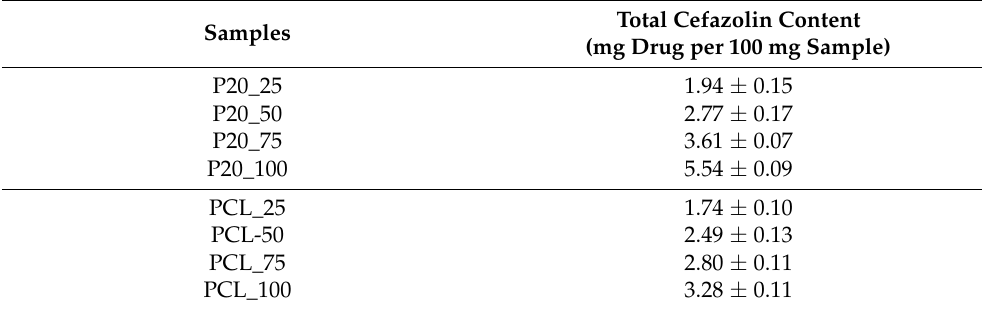
Table 2. Total cefazolin contents loaded in the samples. Data are expressed as mean ± standard deviation